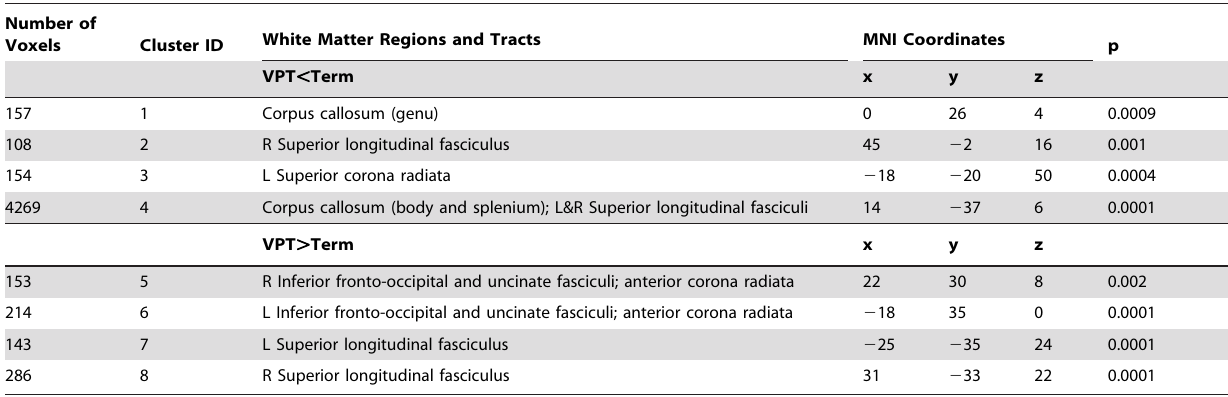
Table 2. Group differences in Fractional Anisotropy